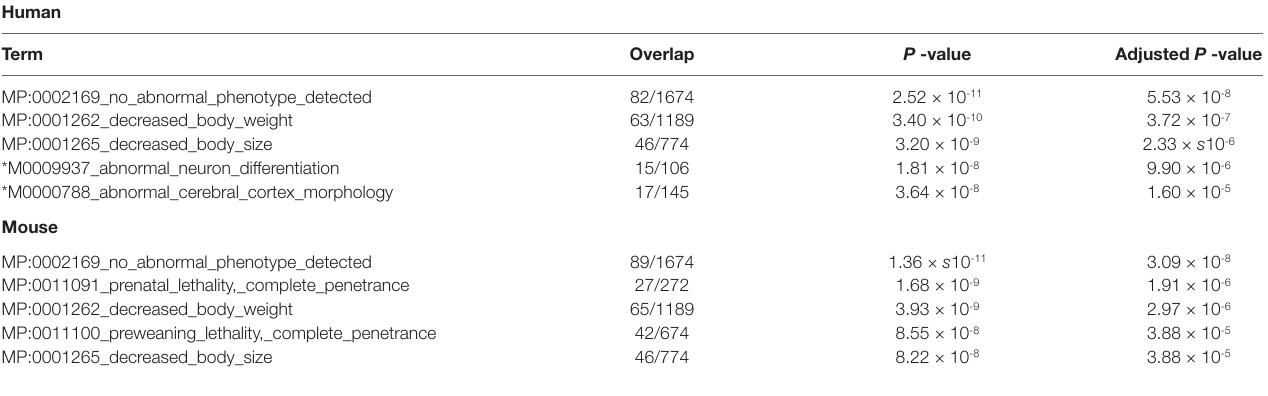
TABLE 8 | Five top-ranked terms from “MGI Mammalian Phenotype 2017” by Enrichr for selected 456 human genes and 505 mouse genes. Brain-related terms are asterisked. Human